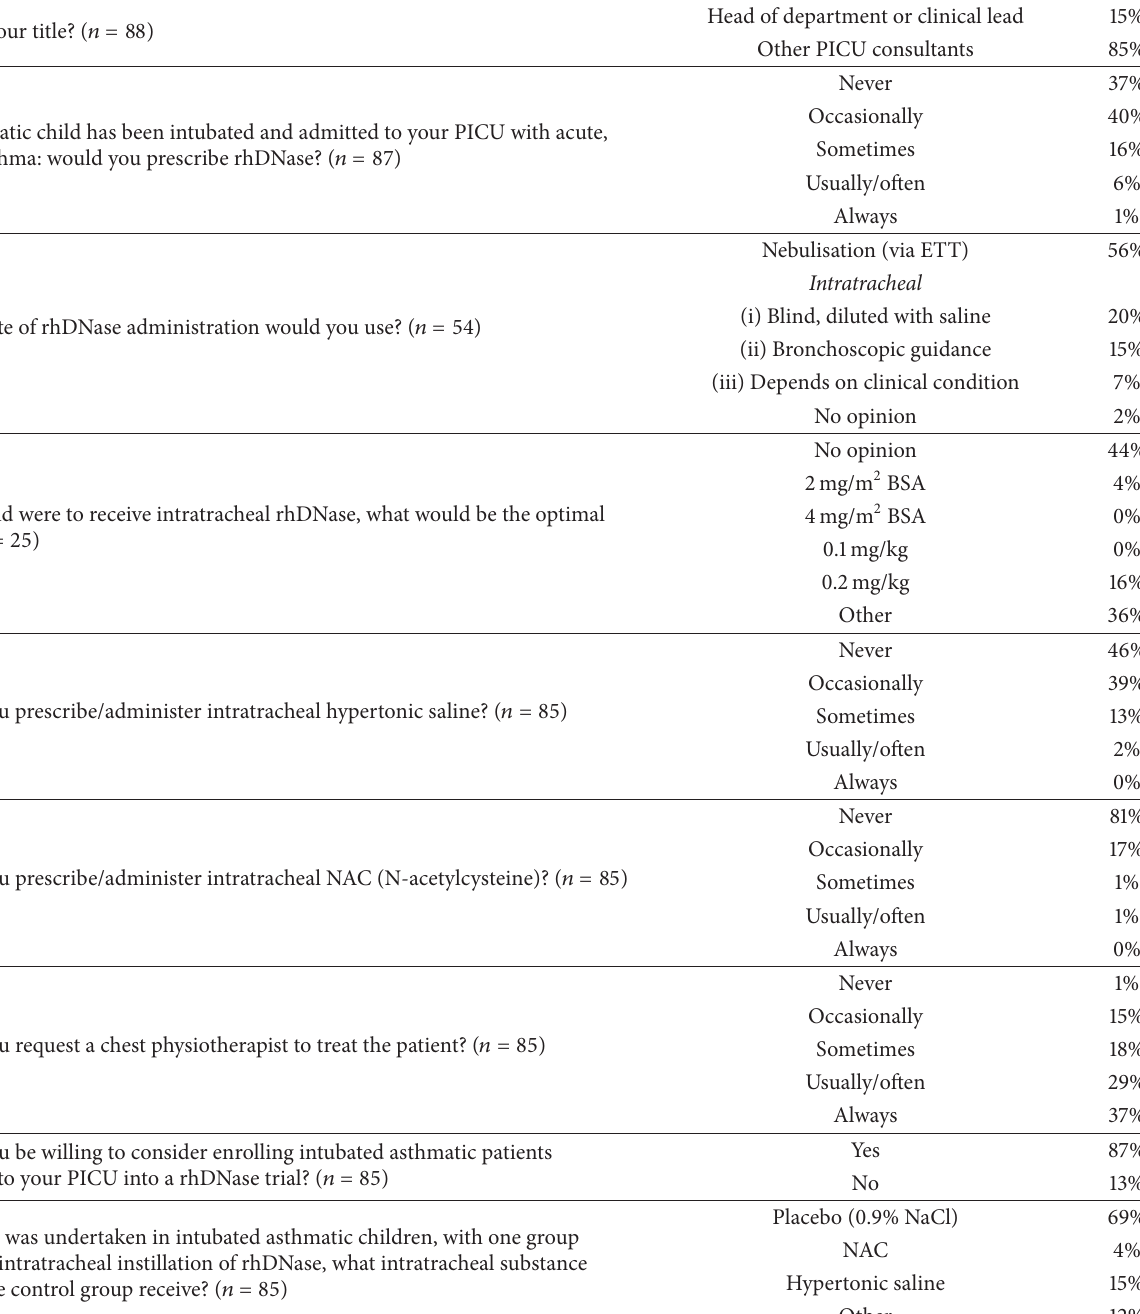
Table 1: Summary of survey questions and